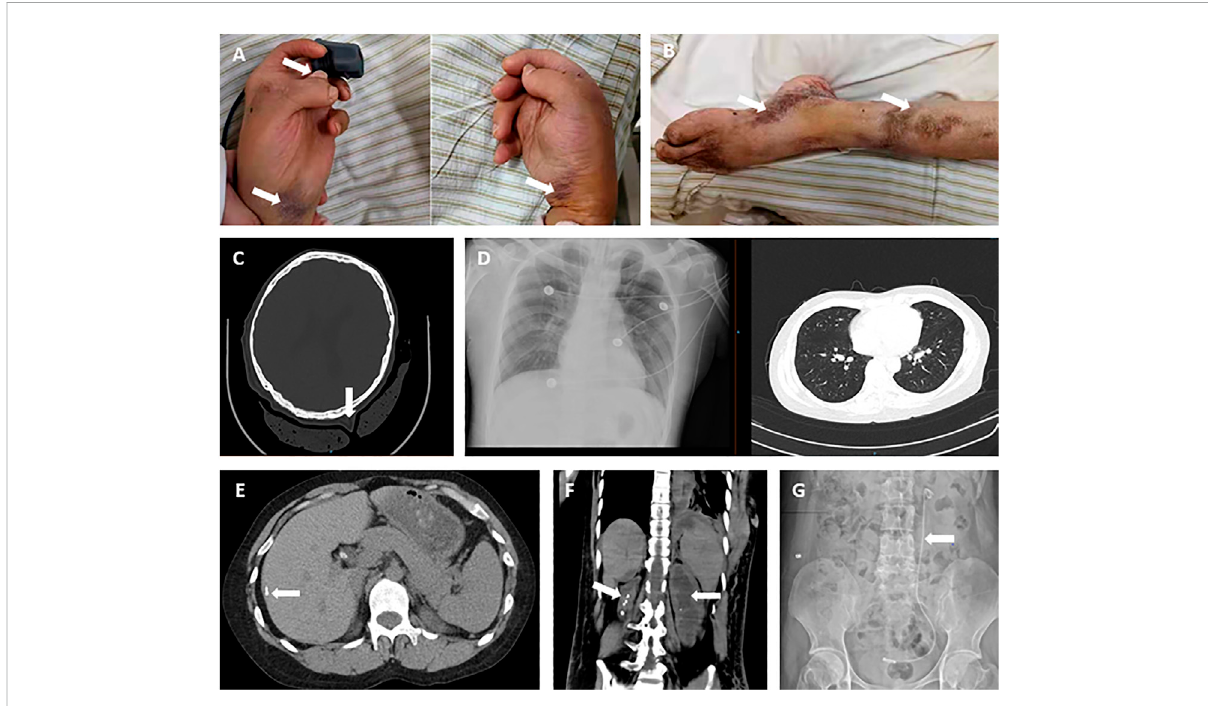
FIGURE 1 Patient ’ s clinical images at admission. (A) Claw-shaped hands with multi- fi nger deformity of the left thumb, with easily bruised and over stretchable skin (arrow). (B) Foot drop deformity (left), with surgical scars on the skin of the leg. (C) Over stretchable soft tissue of head shown on CT image. (D) X-rayimageswerepresentedforthelunginnormalshapeandsize. (E) Calci fi cationsintheliver. (F) Kidneyatrophy(right),hydronephrosis, and renal calculi. (G) J stent in the urinary tract